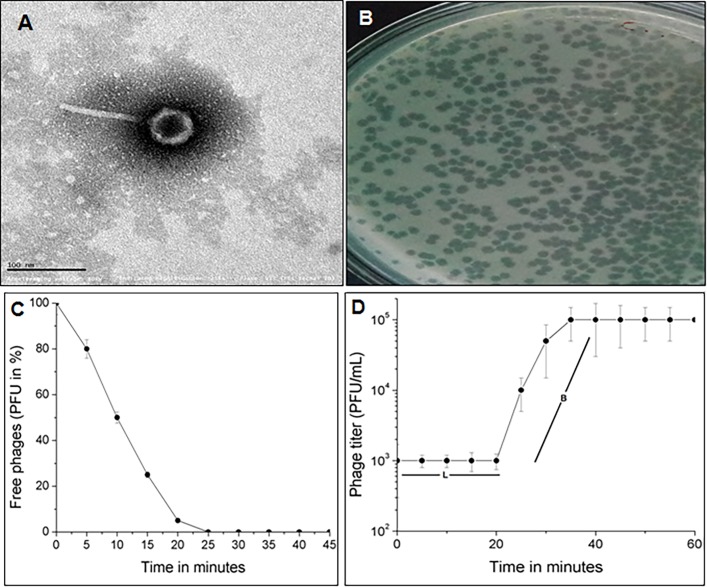
Morphological characterization and life cycle of Escherichia phage myPSH1131.A) Transmission Electron Microscopic (TEM) image of Escherichia phage myPSH1131 shows that the phage belongs to Podoviridae family, B) Observed plaques of Escherichia phage myPSH1131 infecting E. coli PSH131 using double agar overlay method, C) Adsorption velocity of Escherichia phage myPSH1131 showing the adsorption velocity of 1.6x10-9 mL/min, D) One-step growth curve of Escherichia phage myPSH1131 showing the latency period (L) of 20 min and burst size (B) of 130 phage particles/infected cell.